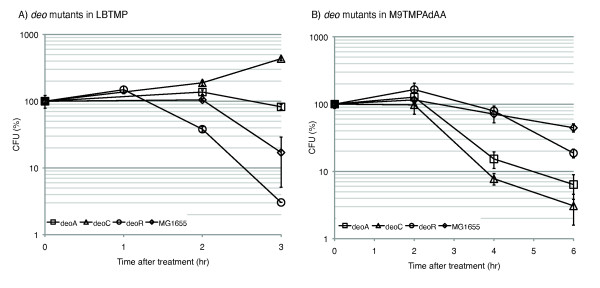
Viability phenotypes of deo- and thyA-deo- mutants in LB and M9 media. A) Mutants in deoC (Δ), deoA (□) and deoR (○) and wild-type E. coli MG1655 (◇) were treated with 50 μg/ml of TMP in LB medium. Viability was tracked by counting CFU's (on LB plates after 16-hr incubation at 37°C) in the cultures sampled at 1, 2 and 3 hours of the treatment. B) In minimal media with supplements M9TMPAdAA.